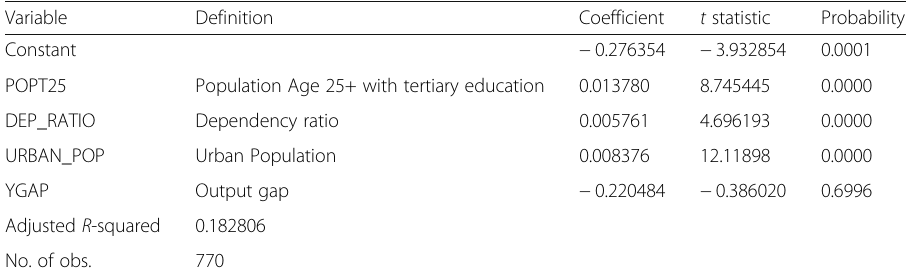
Table 4 TSL vs demographic factors and the state of the business cycle Variable